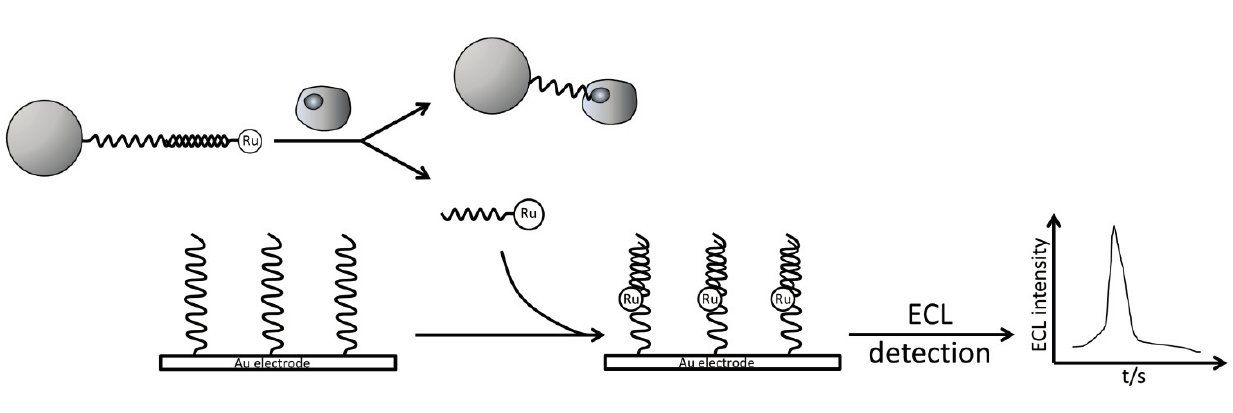
Figure 19. ECL aptasensor for cancer cells detection using Ru(bpy) 32+ as ECL luminophore. Reprinted with permission from ref. [90], copyright (2010) John Wiley and Sons.